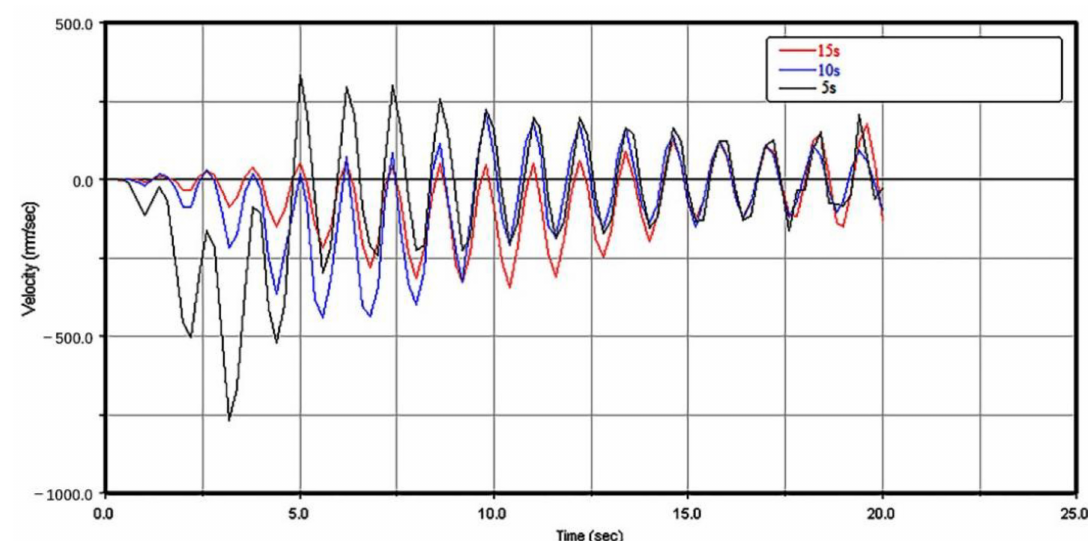
Figure 11. Displacement distribution at different lifting speeds.